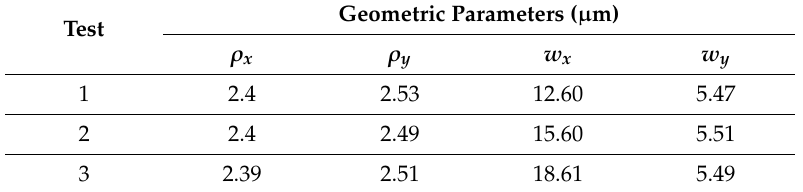
Figure 9. N ormalized IAEs normalized by the maximum of test 2 case for three trial thermopiles. Table 3. Measurement results for the geometric parameters of three proposed thermopiles.